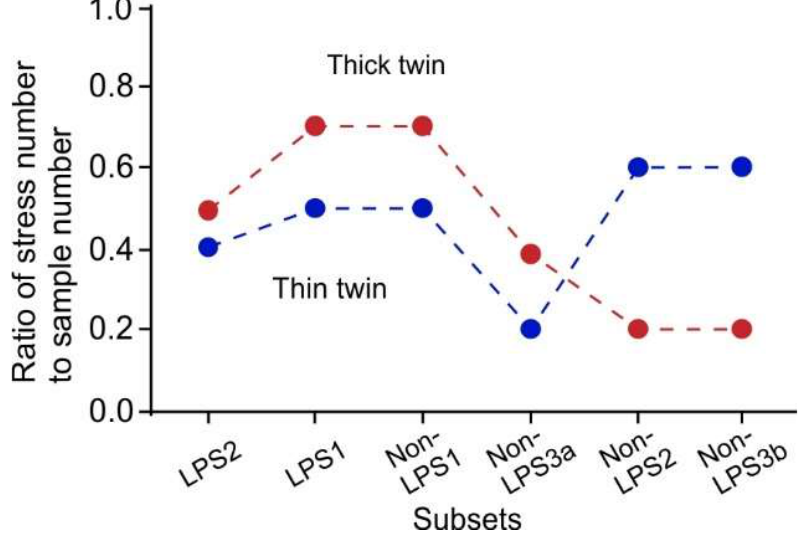
non-LPS1) and non-HDT (non-LPS2 and non-LPS3b). The former group has a larger RES value for thick twins than for thin twins, and the latter group possesses a larger RES value for thin twins. Between the groups is the non-LPS3a subset that has a larger RES value for thick twins.